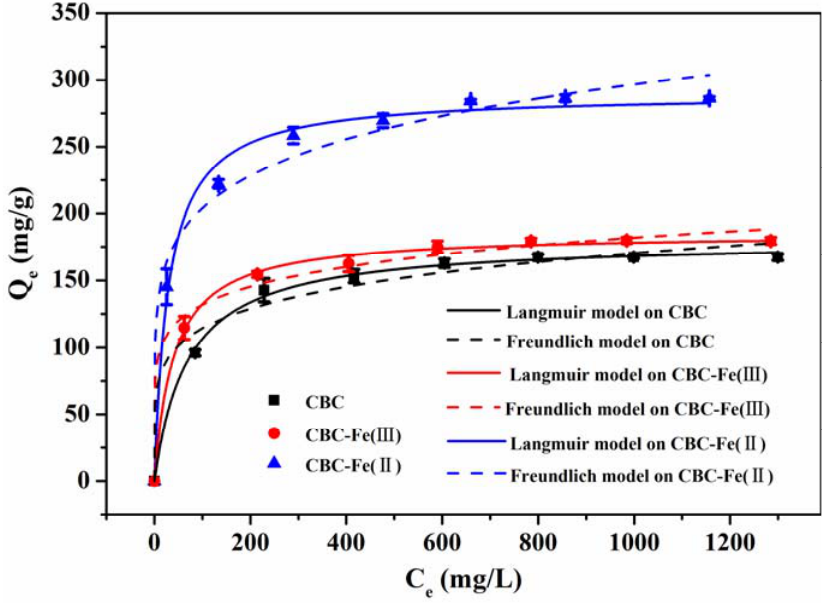
Figure 11. Langmuir and Freundlich isotherms of RhB adsorption by CBC, CBC ‐ Fe(III) and CBC ‐